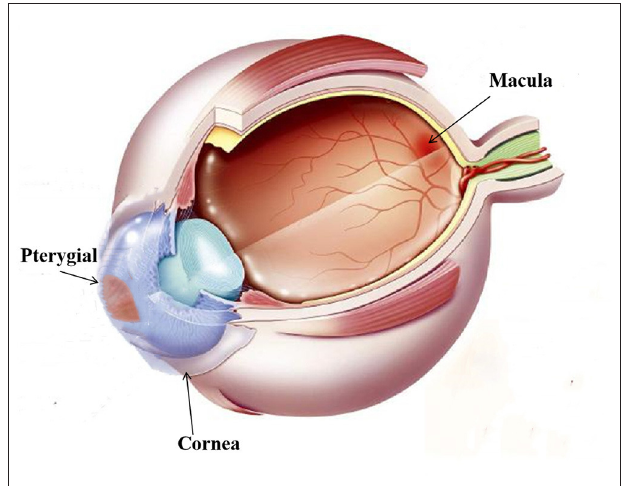
FIGURE 1 | Note clinical photographic imaging using Zeiss slit lamp mounted camera and nihimage J software to measure the size of pterygium. Green,